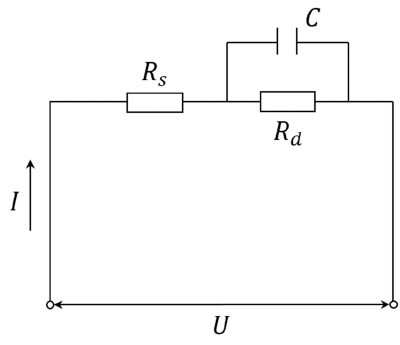
Figure 1. Diesel particulate filter equivalent circuit model.